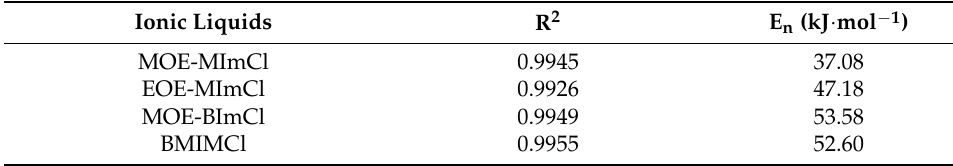
Table 4. The value for R 2 and activation energy (E n ) for ILs.